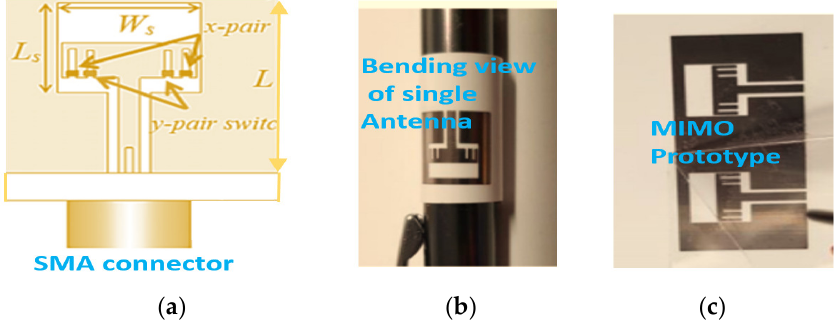
Figure 24. ( a ) The geometry and ( b , c ) prototype of the introduced mm-wave MIMO antenna in